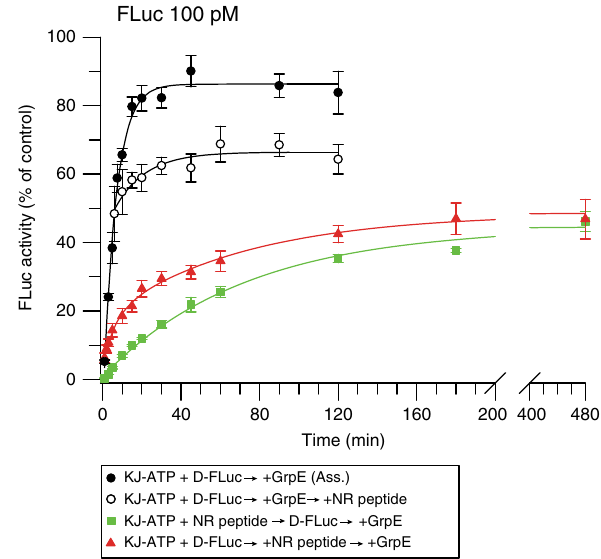
Fig. 7 DnaK commits a fraction of bound FLuc to fast folding. Folding of FLuc in a single-round of chaperone action. Rebinding of FLuc to DnaK was inhibited using excess NR peptide (125 µ M). For single round folding, GuHCl-denatured FLuc was diluted to 100 pM in buffer containing KJ-ATP, followed by addition of NR and initiation of folding with GrpE (red triangles). As controls, NR was either omitted (black circles) or added to KJ-ATP before FLuc (green squares), or after 5 min of chaperone-assisted folding (white circles). Error bars represent s.d. ( n = 3). Ass., KJE-ATP- assisted. Source data are provided as a Source Data fi le.